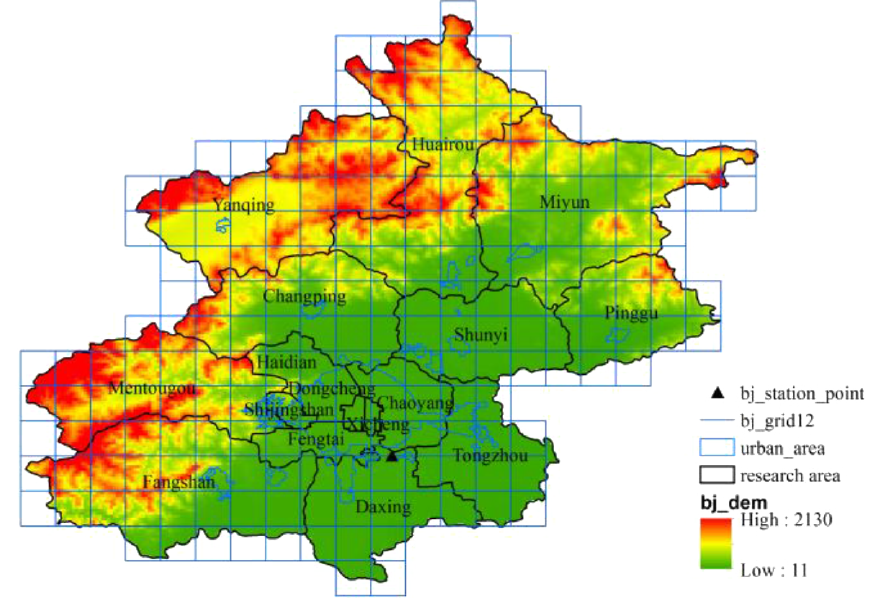
Figure 1. Map of Study Area. (The square grid represents the spatial resolution of the assimilated data, which covers 205 grids in the whole area. The areas in the northern area surrounded by the blue line stand for the urban areas. Elevation is also shown in this